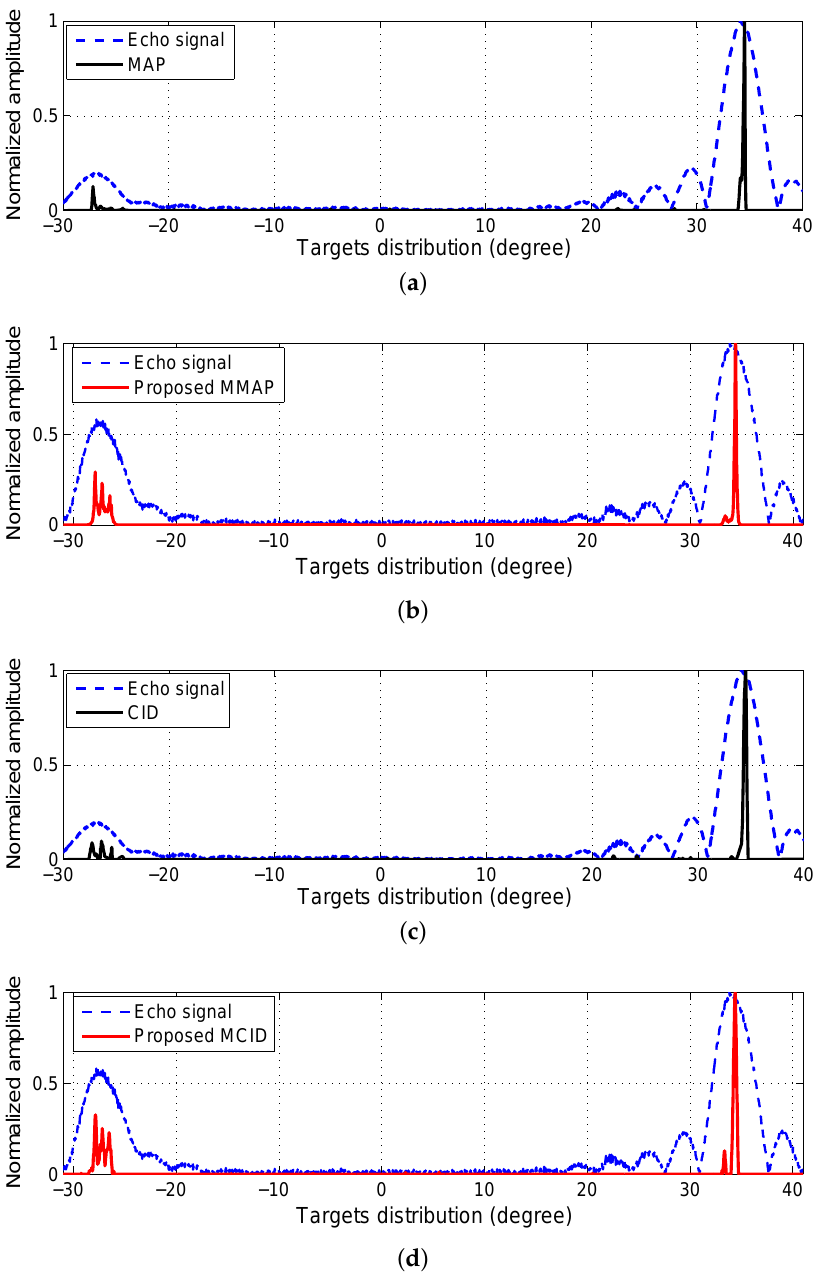
Figure 18. Imaging results of two ships by different methods in range bin. ( a ) MAP; ( b ) Proposed MMAP; ( c ) CID; ( d ) Proposed